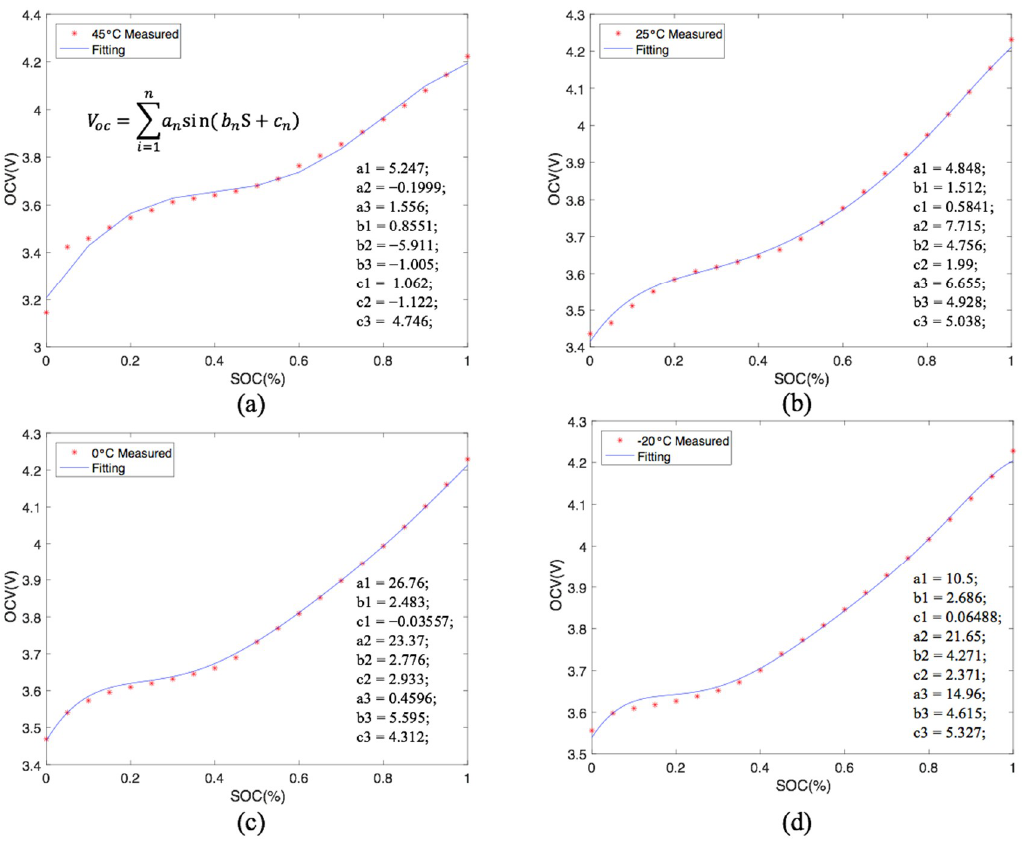
Figure 8. OCV-SOC measured points and sum of sin functions model fitting curves for ( a ) 45 ◦ C; Figure 8. OCV‐SOC measured points and sum of sin functions model fitting curves for ( a ) 45 °C; ( b ) ( b ) 25 ◦ C; ( c ) 0 ◦ C; ( d ) − 20 ◦ C temperatures. 25 °C; ( c ) 0 °C; ( d ) −20 °C temperatures.